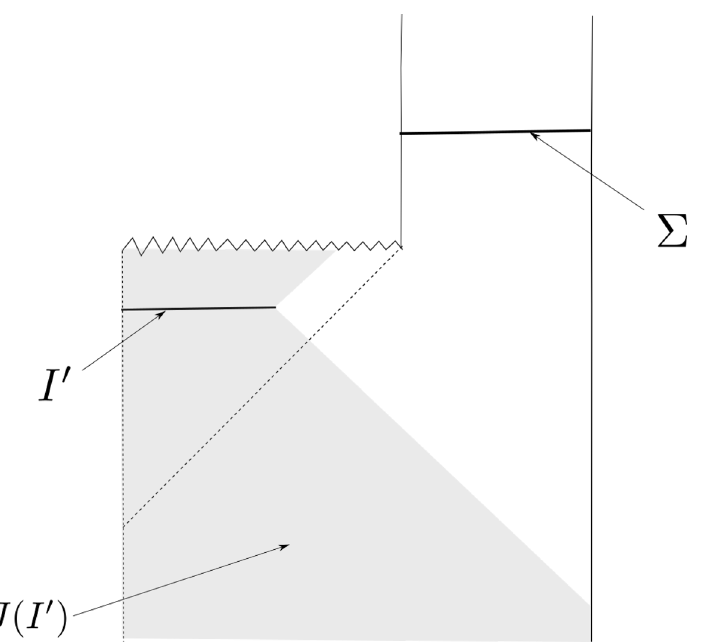
Figure 2 : The Penrose diagram of a small AdS black hole that forms from collapse then evaporates away to nothing. Σ is a time slice. I 0 is a region whose representative ˜ I 0 := Σ ∩ J ( I 0 ) = ? , for which the step (2.6) of the proof in [1] is incorrect. This is an example of the causal structure needed for ˜ I 0 to be empty in the case of I 0 ∪ R